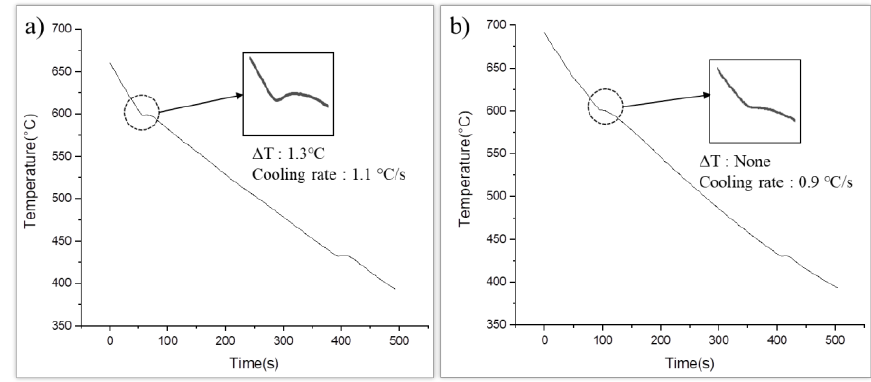
Figure 3. Cooling curves of: ( a ) the commercial - purity AZ91 and ( b ) high - purity AZ91 alloy.